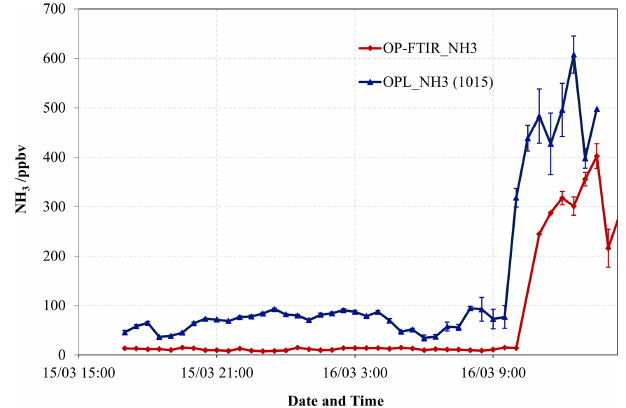
Figure 9. The 30min averaged NH 3 mole fraction measured by the OP-FTIR spectrometer and OPL unit 1015 positioned side-by-side (path length = 148m) at the Wollongong site. Error bars denote the standard error of the 30min